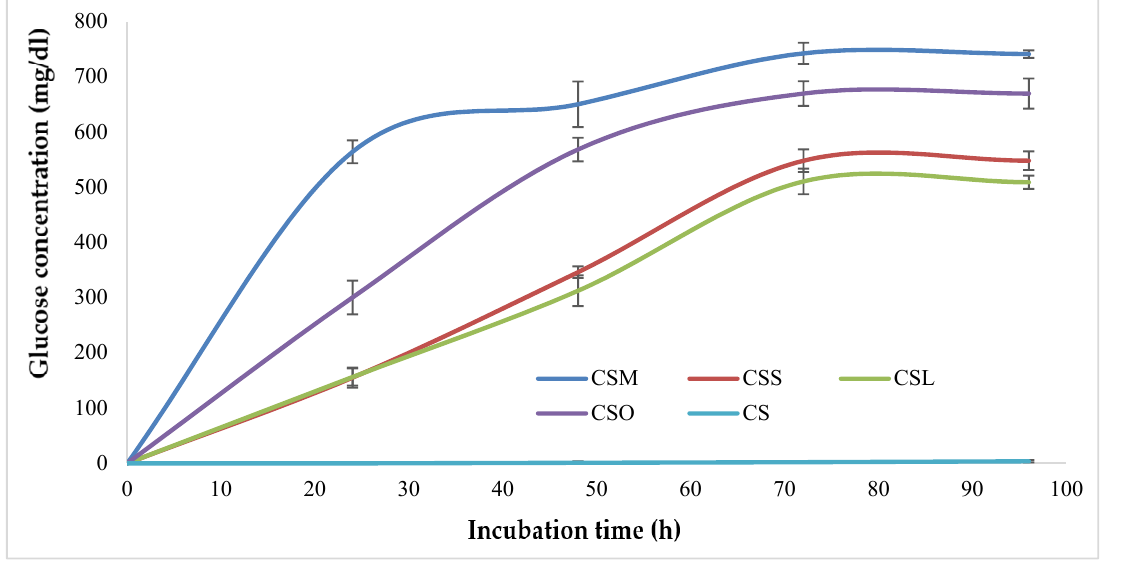
Figure 3. The glucose concentration after various organic acid pretreatments and enzymatic treatments of the solid cellulosic matrices during the incubation period. The enzymatic operating condition: 2% cellulosic matrices in 10 mL acetate buffer (pH 5.5), 100 µL cellulase enzyme ( ≥ 700 U/g), incubated at 50 °C and 150 rpm for 96 h.